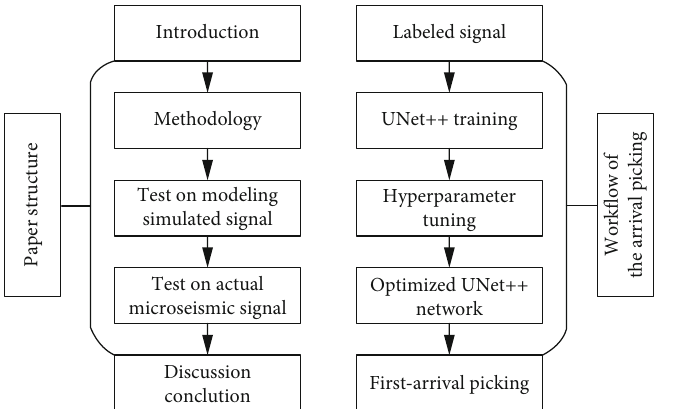
Figure 2: The structure and technical route of the paper.